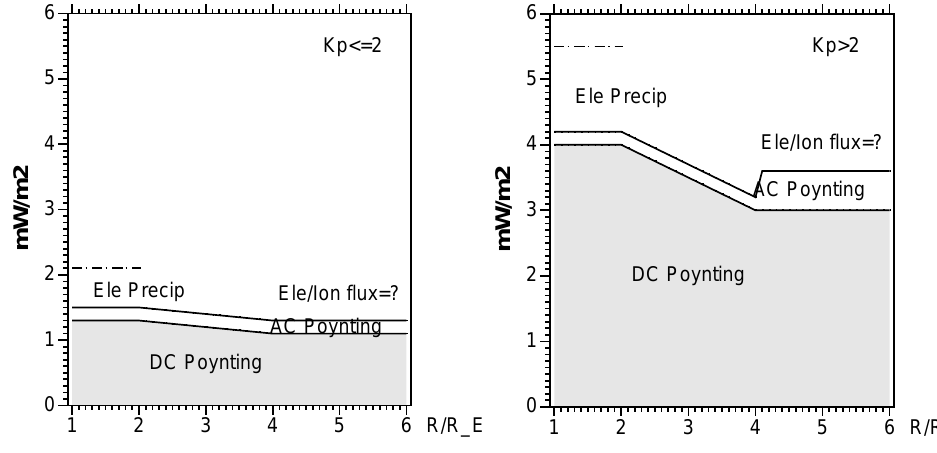
Fig. 7. Schematic description of power per footpoint area of DC Poynting vector, AC Poynting vector (less than 200km ionospheric scale size) and auroral electron precipitation power. The DC Poynting vector is larger than the electron precipitation, which is in turn larger than AC Poynting